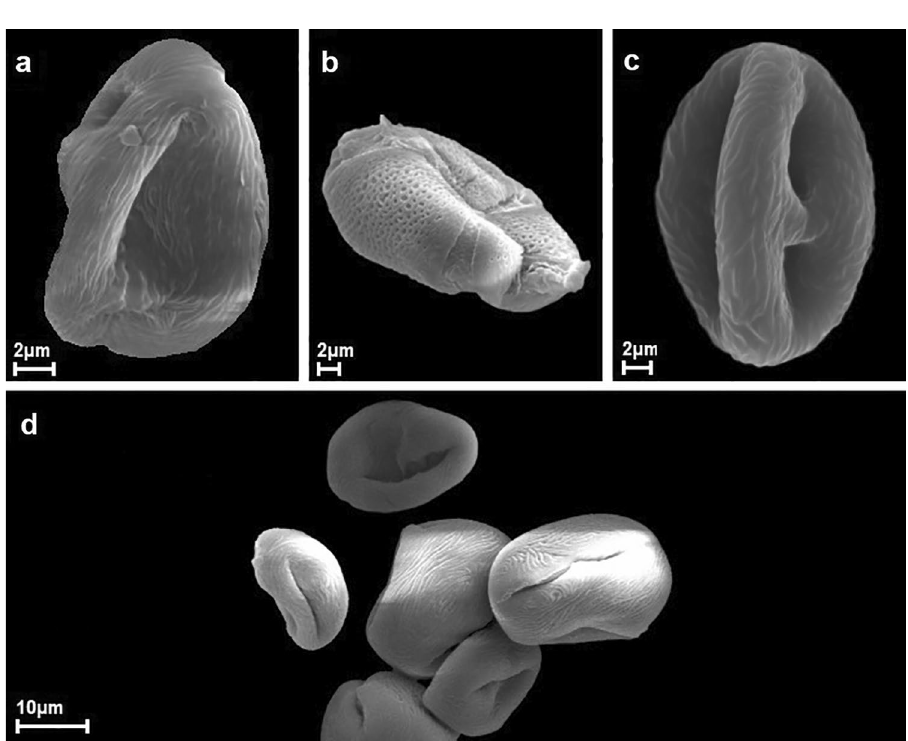
Figure 4. Deformations of pollen grains after application of various herbicides (( a ) – Chwastox, ( b ) – Logo, ( c ) – Mustang, ( d ) –